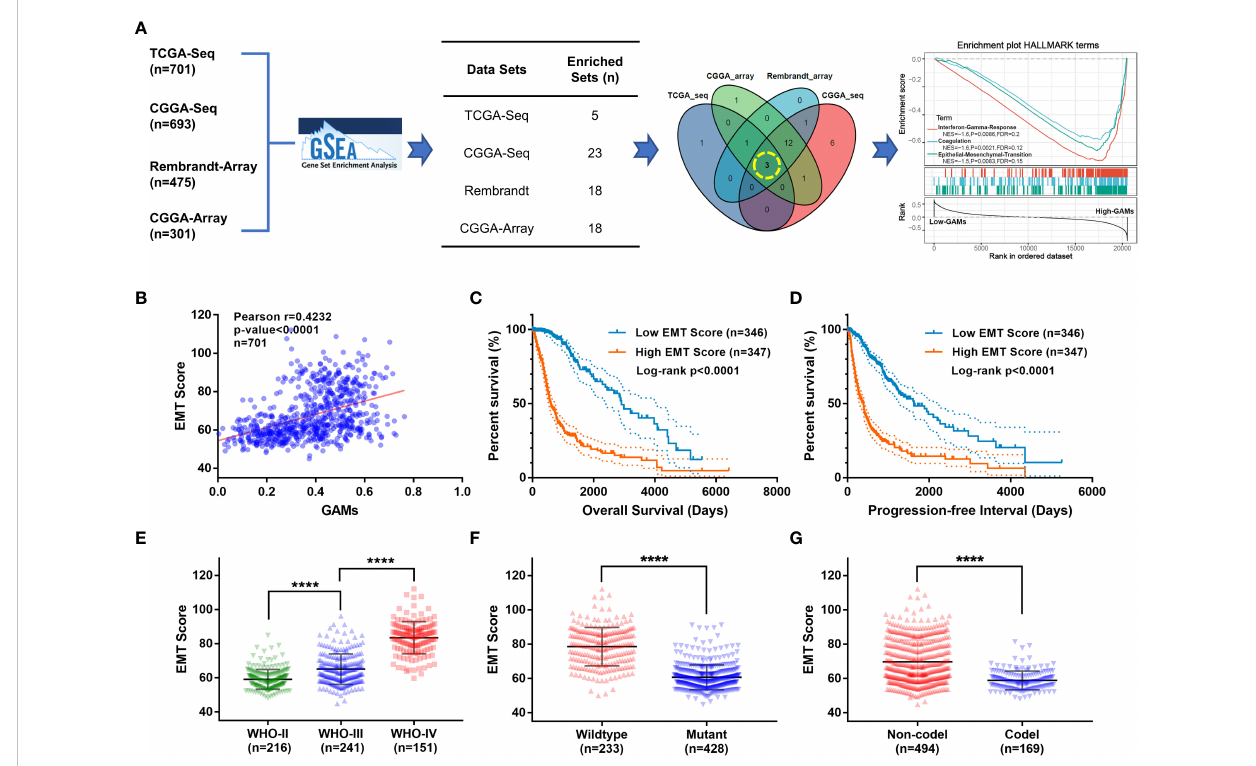
FIGURE 2 Investigation of the most prominent functions of GAMs in glioma samples via bioinformatics analysis. (A) Flow diagram of the bioinformatics investigation of biological functions associated with GAMs in gliomas: GSEA was performed on each glioma dataset (TCGA-seq, CGGA-seq, CGGA- array, and Rembrandt-array) to screen for functional gene sets associated with in fi ltration of GAMs, then the Venn diagram selected the gene sets from GSEA results of multiple datasets. (A. right) The enrichment plot of the three gene sets in samples from the TCGA-seq dataset ranked by GAMs. (B-G) Validation of the clinical features of EMT in the TCGA-seq dataset. (B) Correlation between EMT scores and GAMs content of glioma samples. The overall survival (C) and progression-free survival (D) plots for the glioma patients with different EMT scores. The EMT scores of gliomas with different characteristics, including WHO grades (E) , IDH mutation (F) , and 1p19q co-deletion (G) status. (**** for p-value<